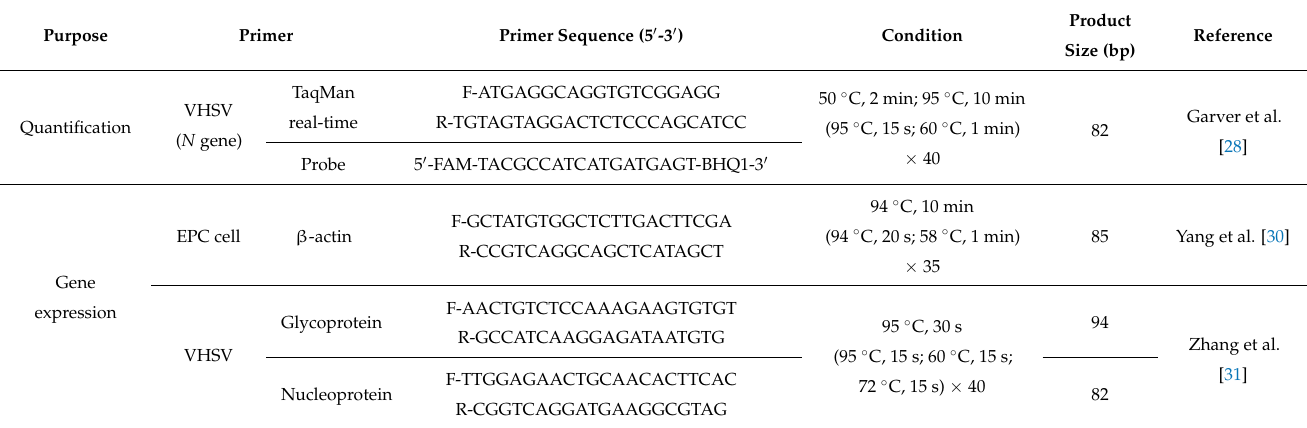
Table 1. Primers uses in this